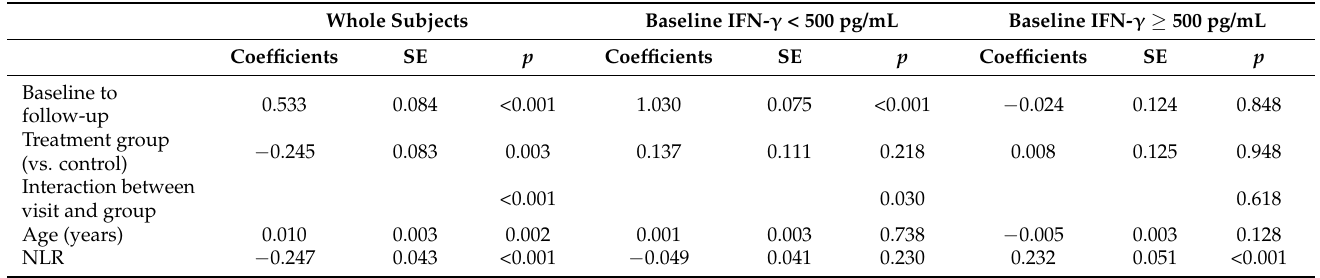
Figure 3. Changes in IFN- γ levels from baseline to follow-up in the treatment and control groups. The markers indicate mean and error bars show sem. ( A ) Analyses of the whole subjects show a significant increase in IFN- γ levels only in the treatment group. ( B ) In the subgroup with low baseline IFN- γ levels, IFN- γ levels significantly increased in both groups. ( C ) In the subgroup with normal baseline IFN- γ levels, IFN- γ levels significantly decreased in the control group. p values were calculated using paired t -test. Table 4. The unstandardized coefficients of the variables in the generalized estimating equation